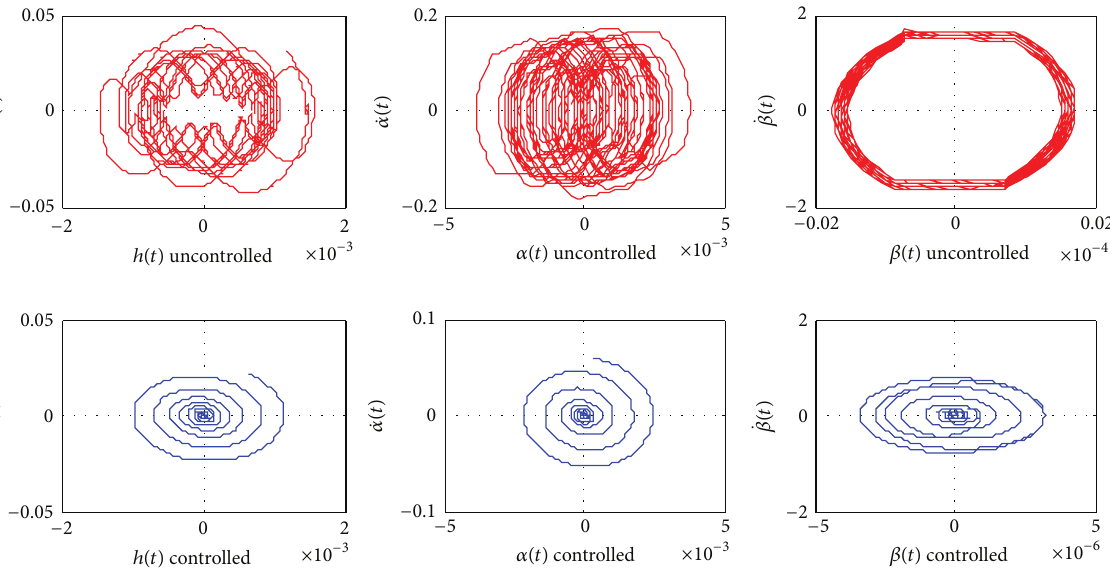
Figure 13: Case 1: phase plan ( |𝛿| = 0.4 ∘ and 𝑉 = 12.5 m/s).